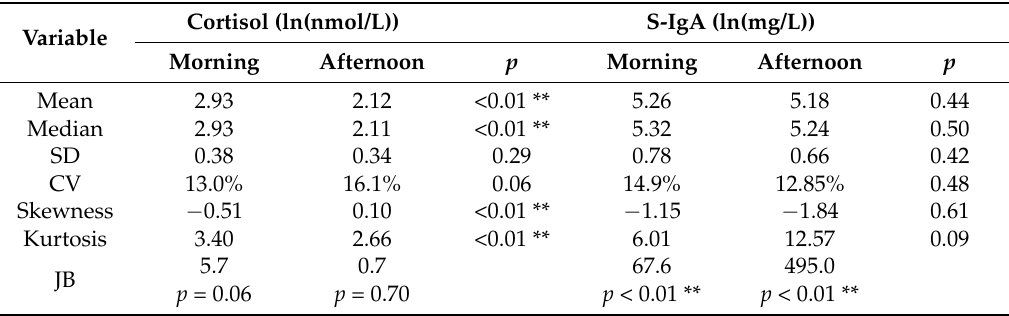
Table 3. Characteristics of the distribution of log-transformed salivary cortisol and immunoglobulin A